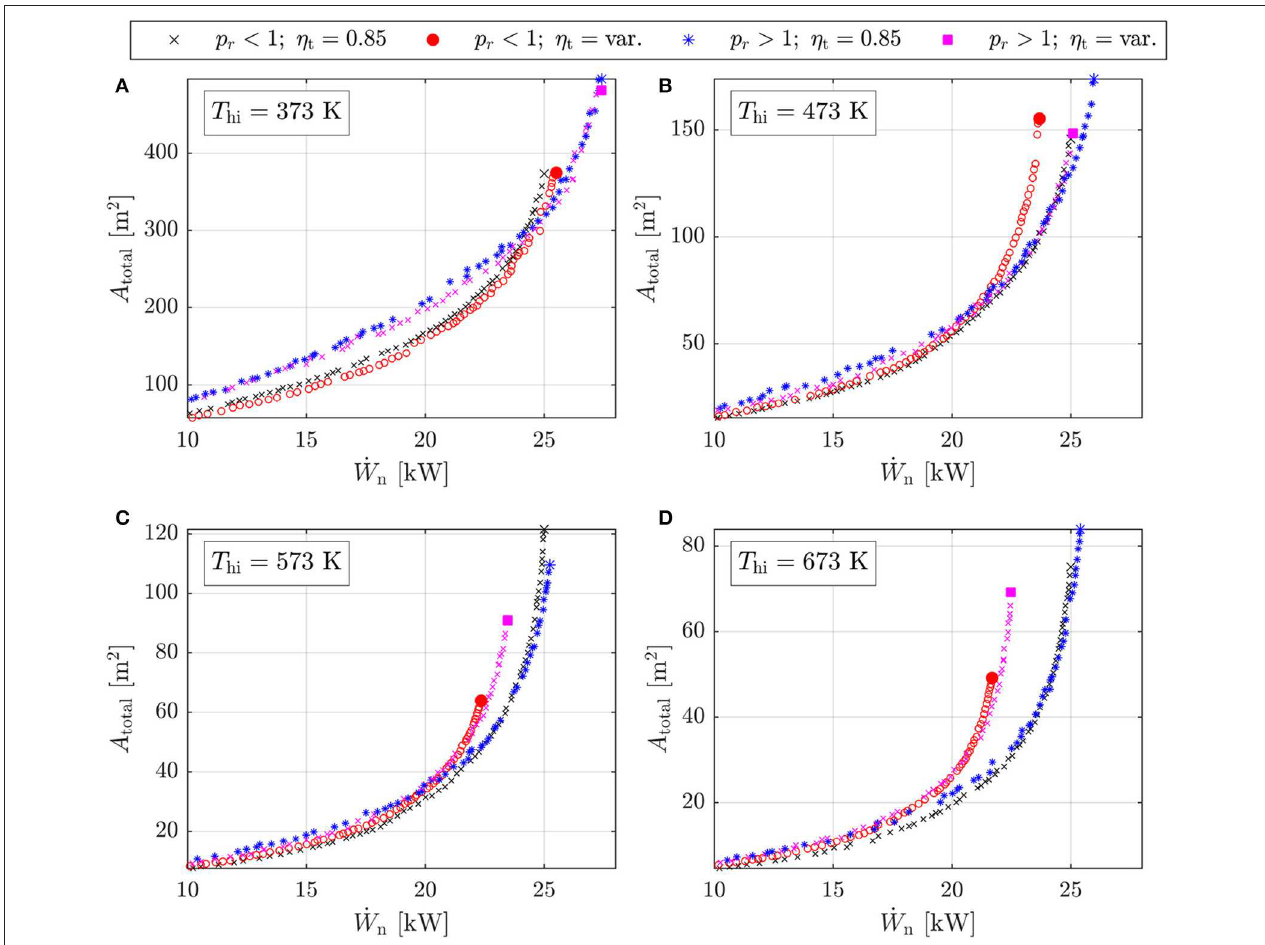
FIGURE 10 | Pareto fronts identified from the multi-objective optimization for the subcritical ( p r < 1) and transcritical ( p r > 1) cycles using the fixed ( η = 0.85) and variable ( η = var.) efficiency models: (A) T hi = 373 K; (B) T hi = 473 K; (C) T hi = 573 K; (D) T hi = 673